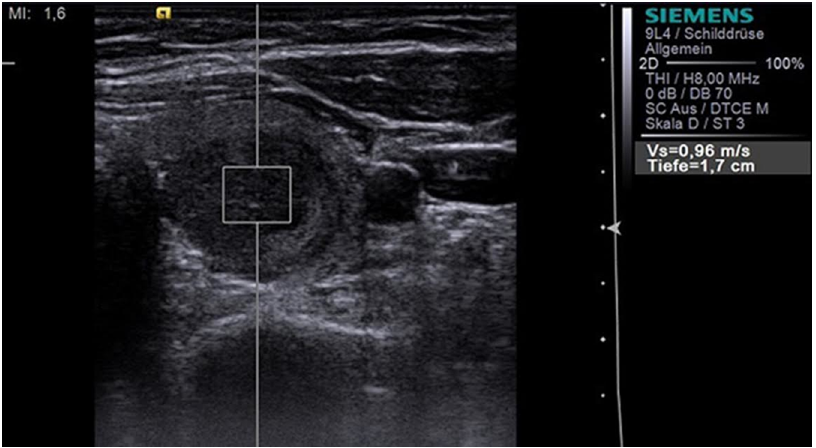
Fig 2. Acoustic Radiation Force Impulse Imaging (S2000, 9L4 probe at 9MHz) with the ROI placed within a hypoechoic thyroid nodule in the left thyroid lobe measuring a velocity of 0.96 m/s. Histology revealed benign